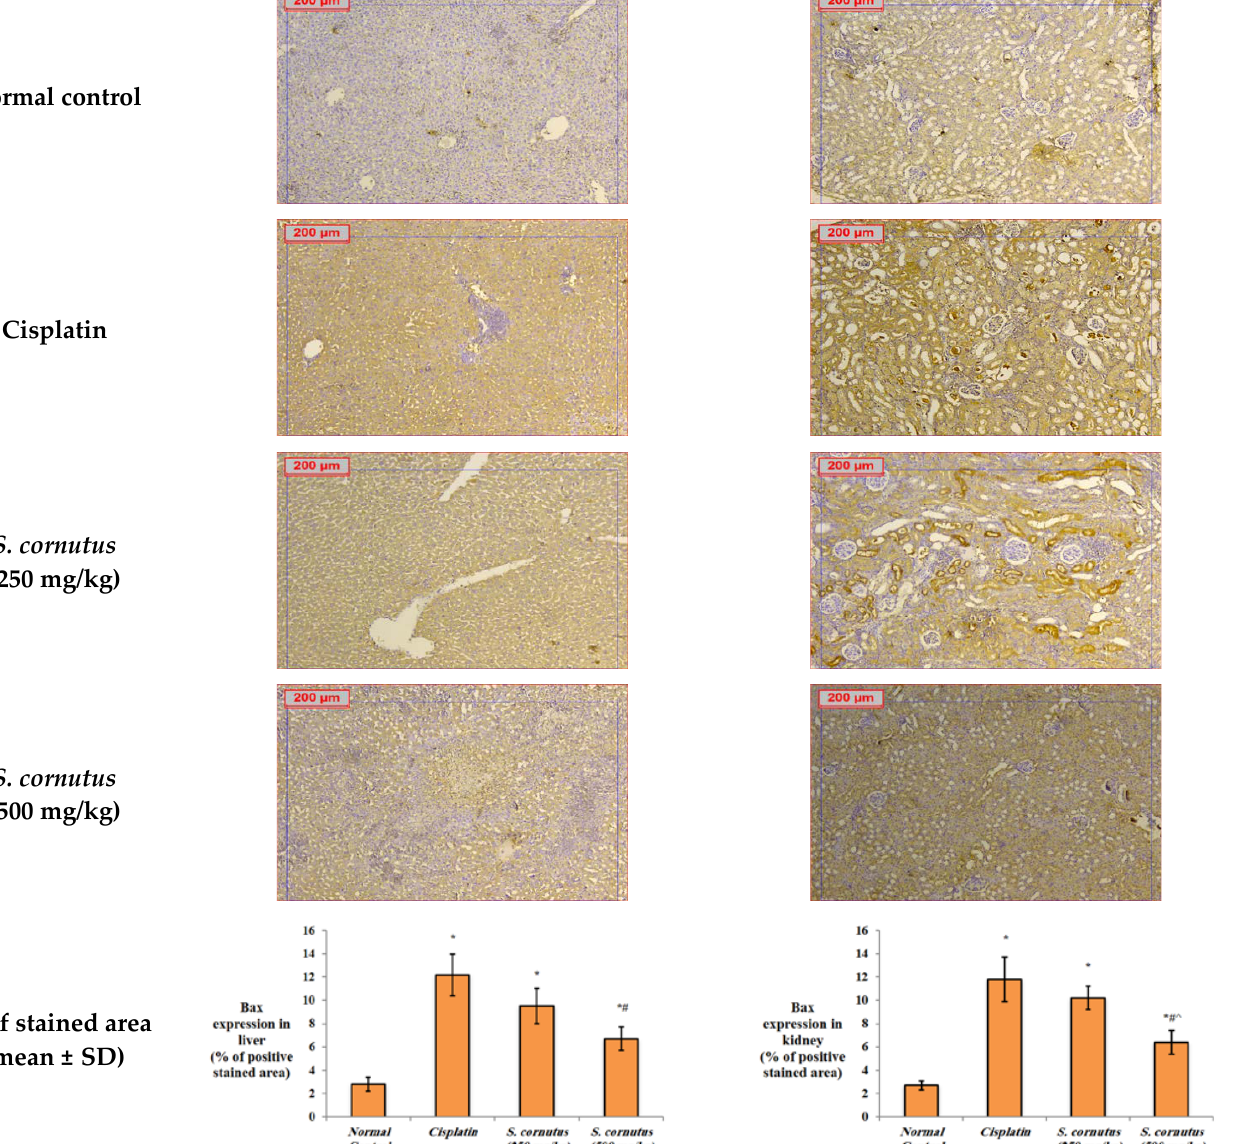
Figure 5. The effect of S. cornutus crude extract on the expression levels of Bax determined by immunohistochemistry in the ( A ) liver and ( B ) kidney tissues of the experimental mice. Data of the percentage of positive stained area are expressed as mean ± SD and analyzed using one-way ANOVA followed by Bonferroni’s post hoc test ( n = 8). * significantly different vs. the normal control group; # significantly different vs. the cisplatin group; ^ significantly different vs. the S. cornutus (250 mg/kg) group. Differences were considered significant at p < 0.05.